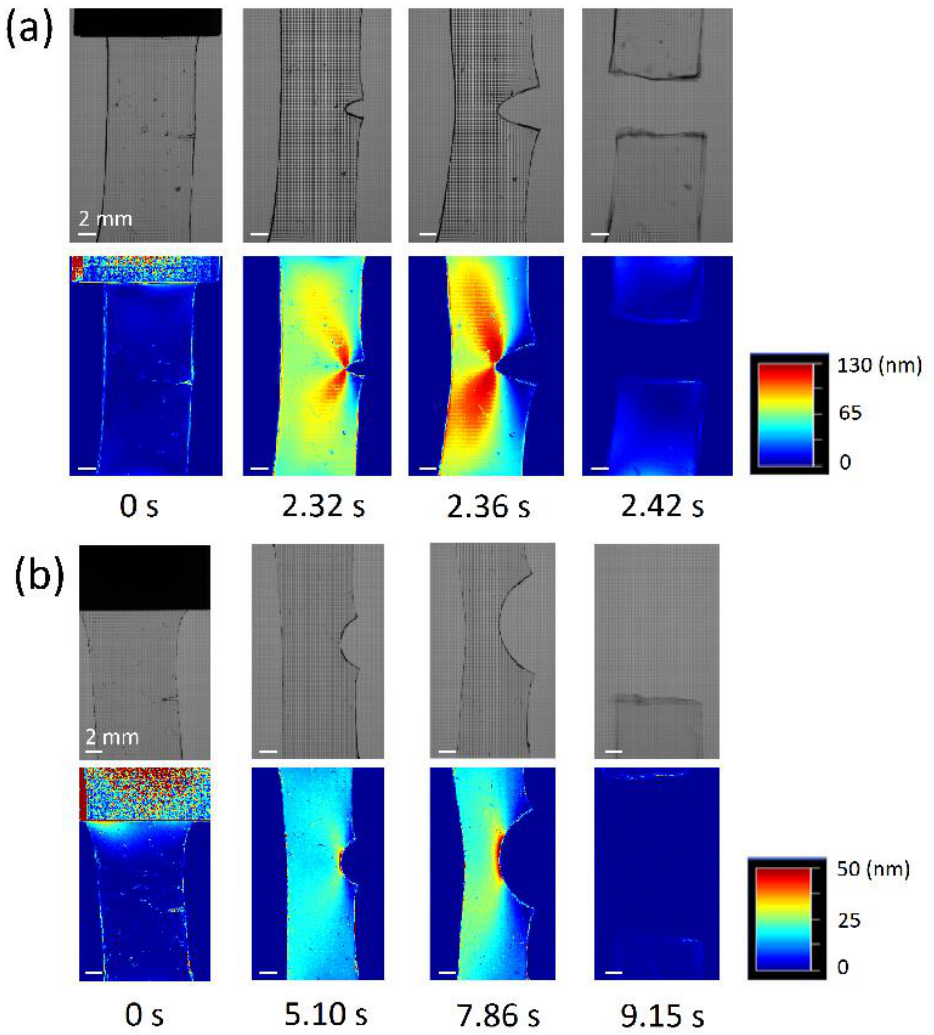
Figure 14. Gray scale photos and retardation maps of ( a ) SR gel with 25% CD coverage and ( b ) SR gel with 2% CD coverage during crack propagation. Reprinted from [29] with permission from IOP Science.